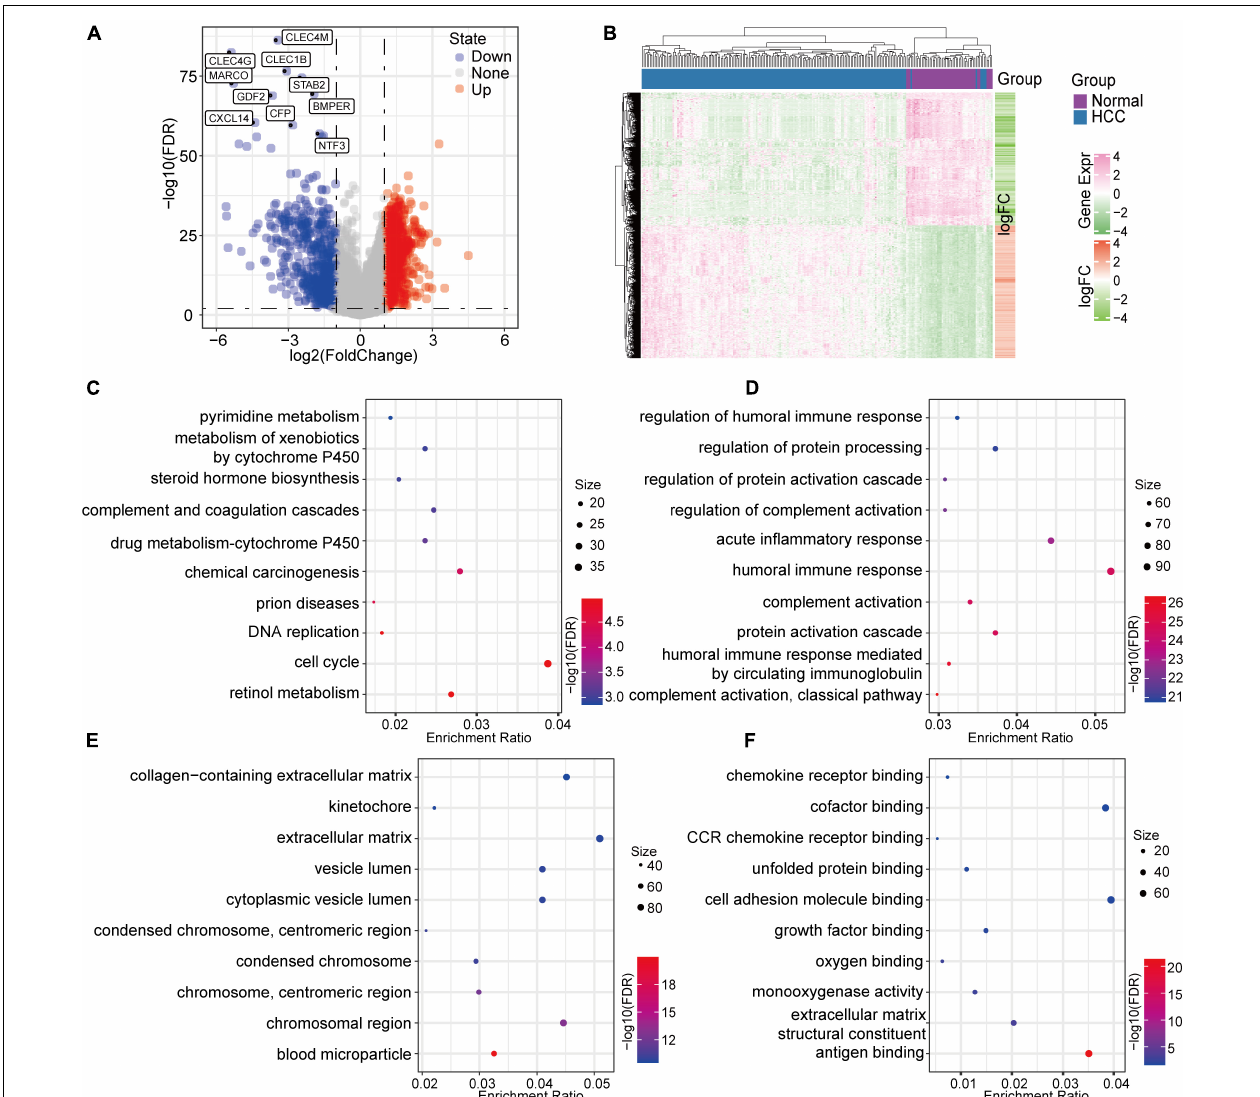
FIGURE 3 | Identification and characteristics of the DEGs based on PD-1-negative HCC samples. (A) A volcano map of the DEGs. (B) A differential-expression heat map of the normal and HCC samples. (C) KEGG annotation analysis of the DEGs. (D) Gene ontology biological-function enrichment analysis of the DEGs. (E) DEG analysis for gene ontology cell-component enrichment. (F) Molecular function enrichment analysis of the